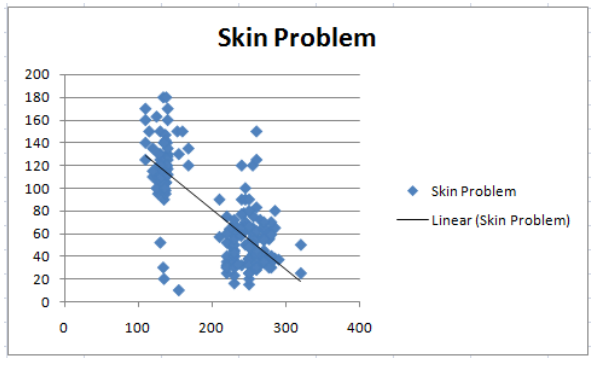
Figure 11. Correlation between skin problem and diabetic